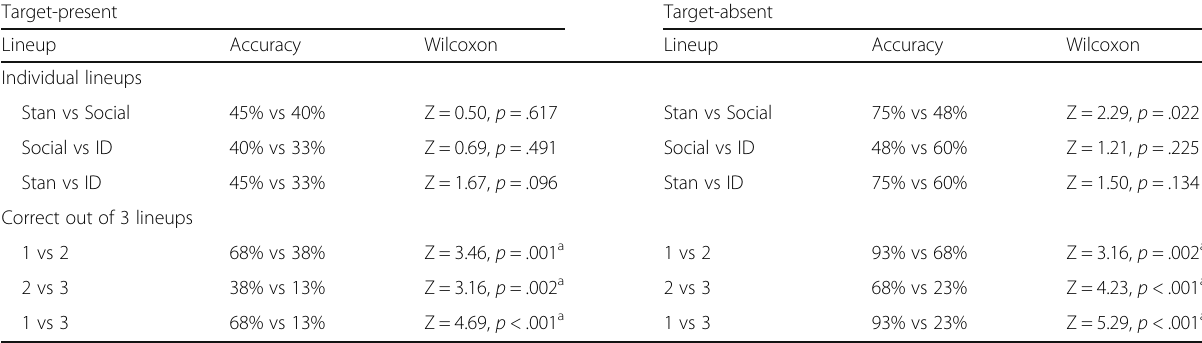
Table 2 A summary of statistical comparisons (Wilcoxon signed-rank test) for individual lineup accuracy and for accuracy out